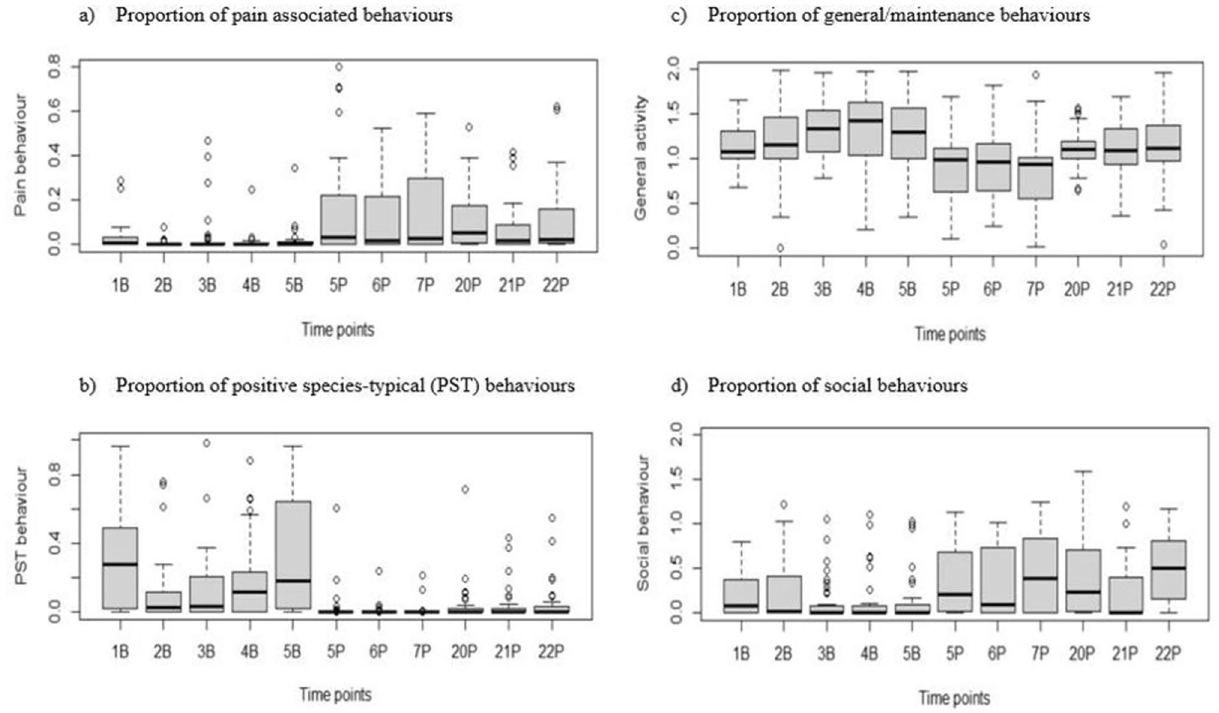
Figure 4. Behavior changes reliably at specific times in primates following surgery related to breakthrough pain. Boxplot showing the proportion of time selected behaviors occur across time from up to 168 h prior to surgery to 24 h post-surgery (n = 43 animals). The solid line indicates the median, the grey box indicates the interquartile range, the whiskers indicate the range, and the circles indicate the extreme values. Timepoints start from up to 168 h before surgery (1B: 06:30–07:30 (cohort 1) or 07:00–08:00 (cohort 2), 2B: 12:00–13:00, 3B:16:00–17:00, 4B:17:00–18:00, 5B:18:00–19:00) and up to 24 h post-surgery ((5P:16:00–17:00 (3 h post-op), 6P:17:00–18:00 (4 h post-op), 7P:18:00–19:00 (5 h post-op), 20P: 06:30–07:30 (cohort 1) or 07:00–08:00 (cohort 2)(17 h post-op), 21P: 12:00–13:00 (20 h post-op), and 22P: 17:00–18:00 (24 h